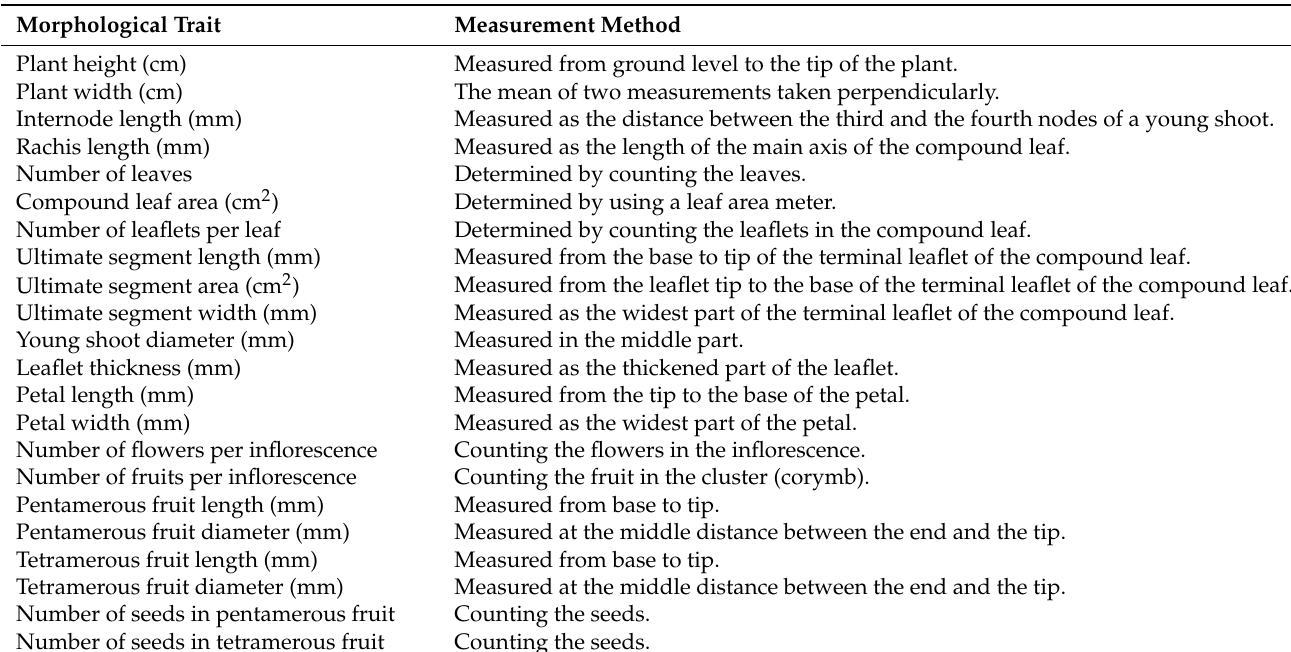
Table 2. Morphological traits of R. chalepensis populations identified in northern parts of Jordan and the measurement methods used in this